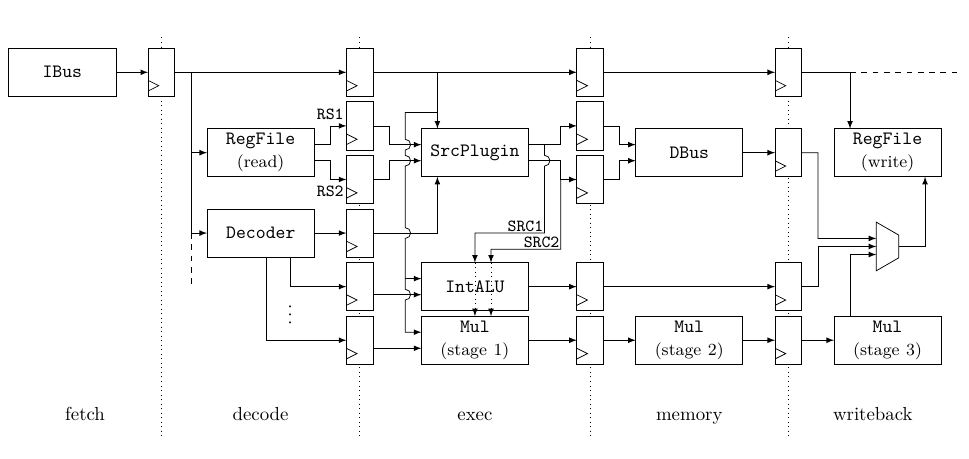
Figure 1: The simplified architecture of the VexRiscv